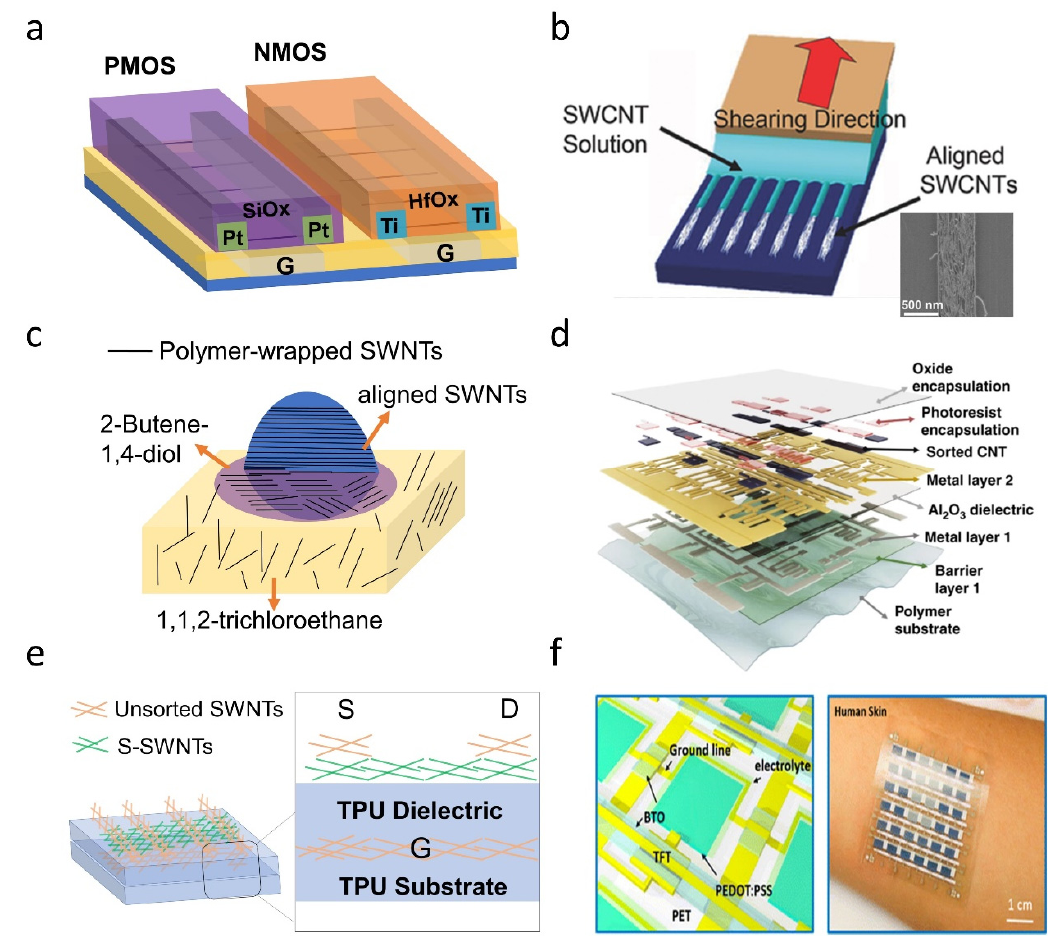
Figure 11. ( a ) Carbon nanotube (CNT)-based CMOS achieved by using dielectric doping (SiO x for p-doping and HfO x for n-doping) and metals with suitable work functions (Pt for p-type contacting and Ti for n-type contacting); ( b ) solution-shearing method for CNT alignment and the SEM image of the well-aligned SWNTs. Reprinted with permission from Park, S. et al., 2015. Copyright 2015 John Wiley and Sons; ( c ) dimension-limited self-alignment (DLSA) method for CNT alignment; ( d ) layer structure of high-performance flexible logic circuits operating at low voltage. Reprinted with permission from Lei, T. et al., 2019. Copyright 2019 Springer Nature; ( e ) stretchable and twistable SWNT transistor device based on polyurethane (TPU); ( f ) diagram of large-area and fully screen-printed active-matrix electrochromic displays (AMECD), based on flexible PET substrate and the photograph of that flexible AMECD sticking on human arm and displaying a picture of “U”. Reprinted with permission from Cao, X. et al., 2016. Copyright 2016 American Chemical